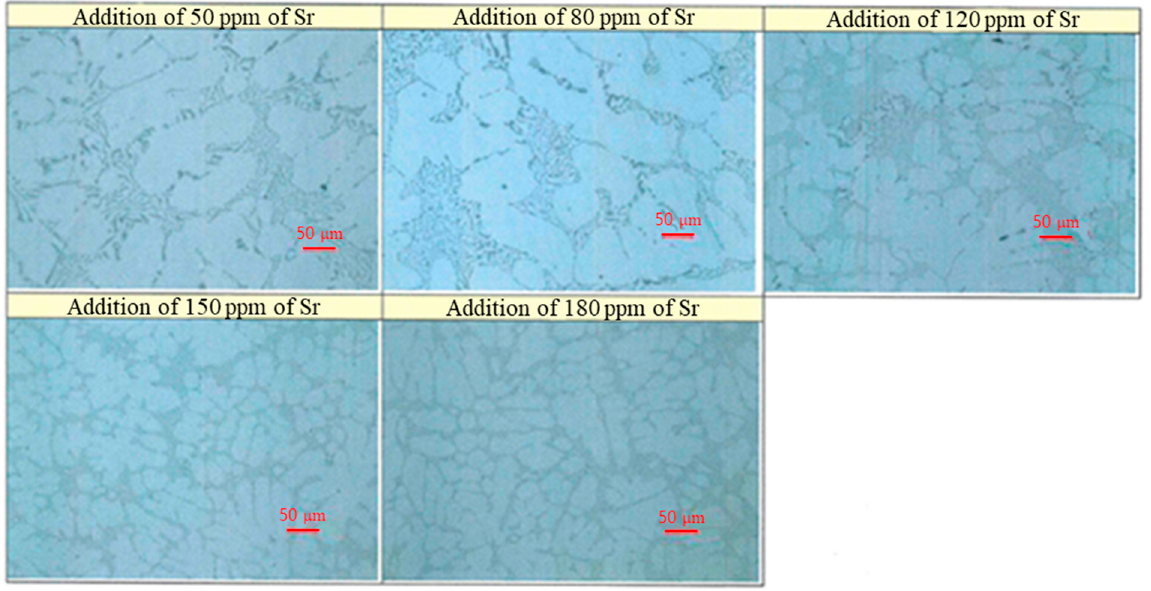
Figure 6. Comparison of Si structures obtained by adding 60 ppm P to the molten alloy and varying the amount of